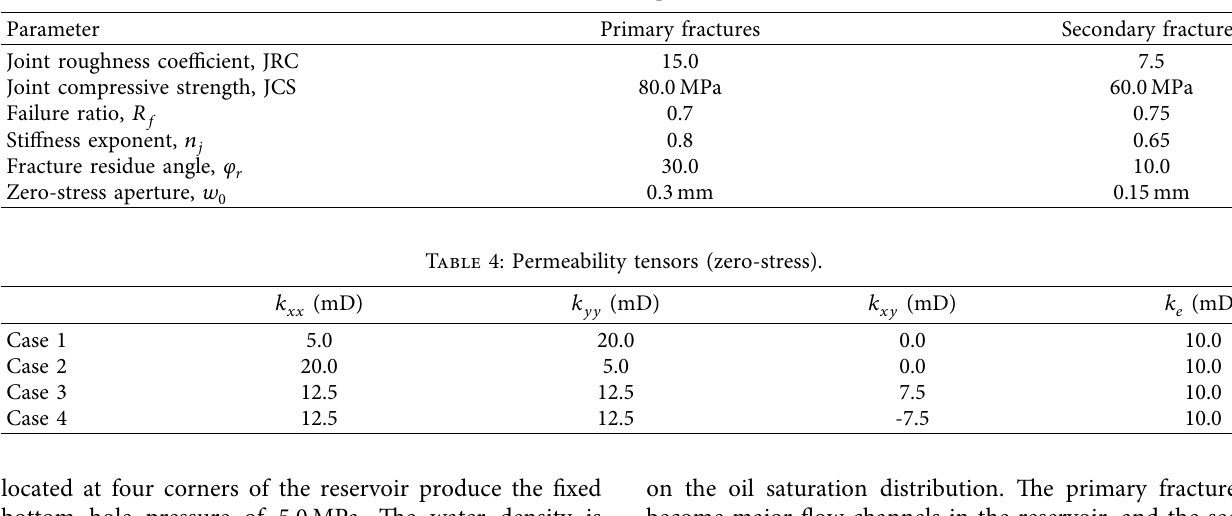
Figure 24: (a) Configuration of the reservoir. (b) Grids in the reservoir. Table 3: Fracture